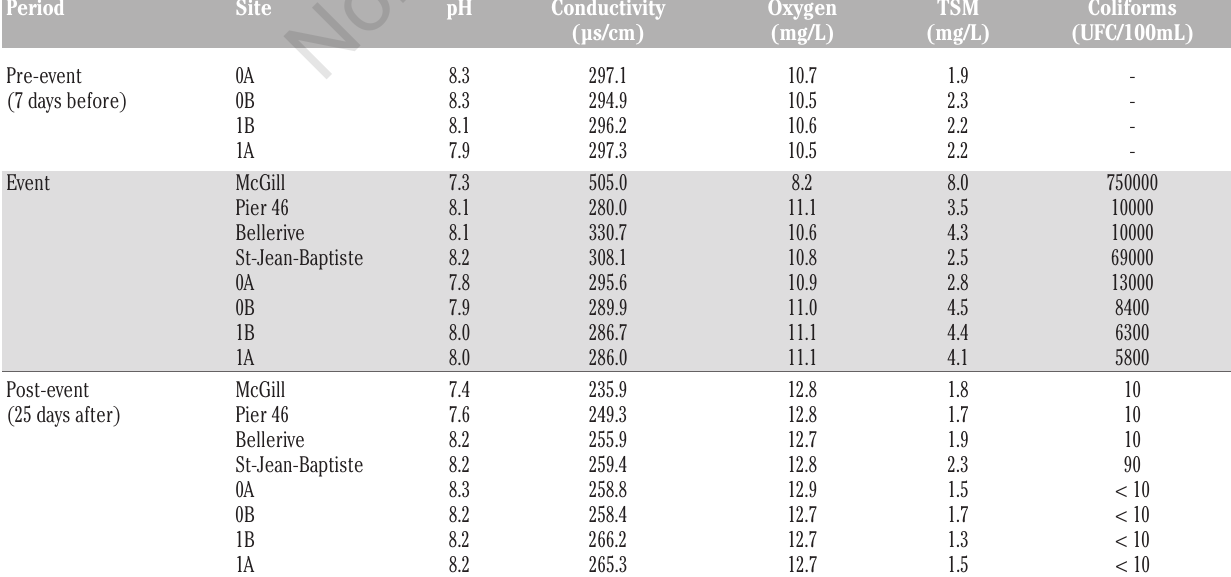
Table 1. Water quality parameters measured prior, during and after the untreated wastewater discharge event. Period Site